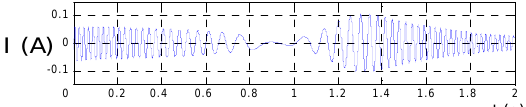
Fig. 4. Transient evolution of the LSC during the startup.